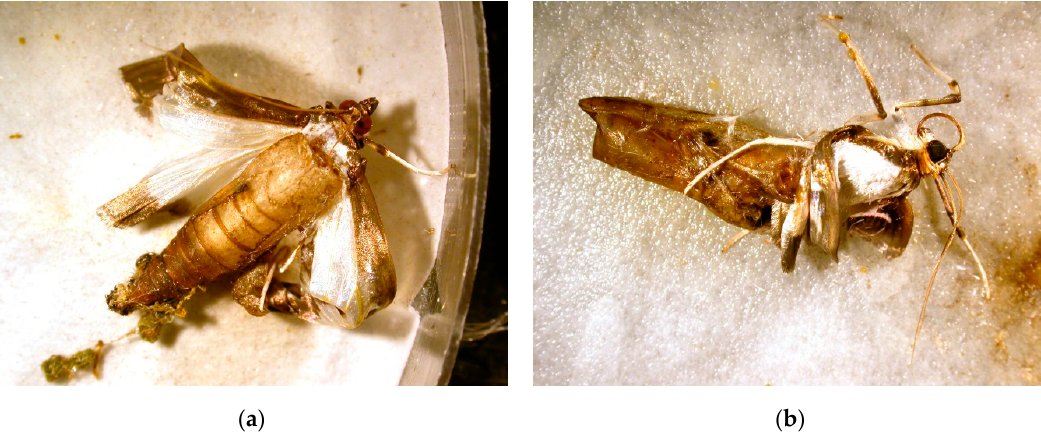
Figure 1. ( a ) Early mycosis of Isaria fumosorosea on Cydalima perspectalis pupa; ( b ) Cadaver of C. Figure1. ( a )Earlymycosisof Isariafumosorosea on Cydalimaperspectalis pupa; ( b )Cadaverof C.perspectalis perspectalis covered with sporulating fungus. covered with sporulating fungus.